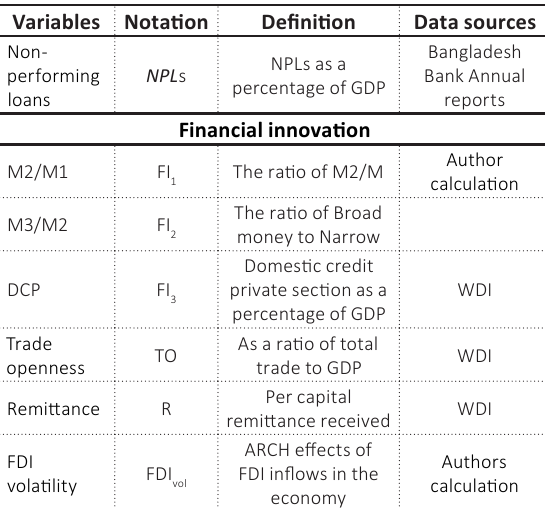
Figure 1. Conceptual model for hypotheses Table 1. Variable definition and sources